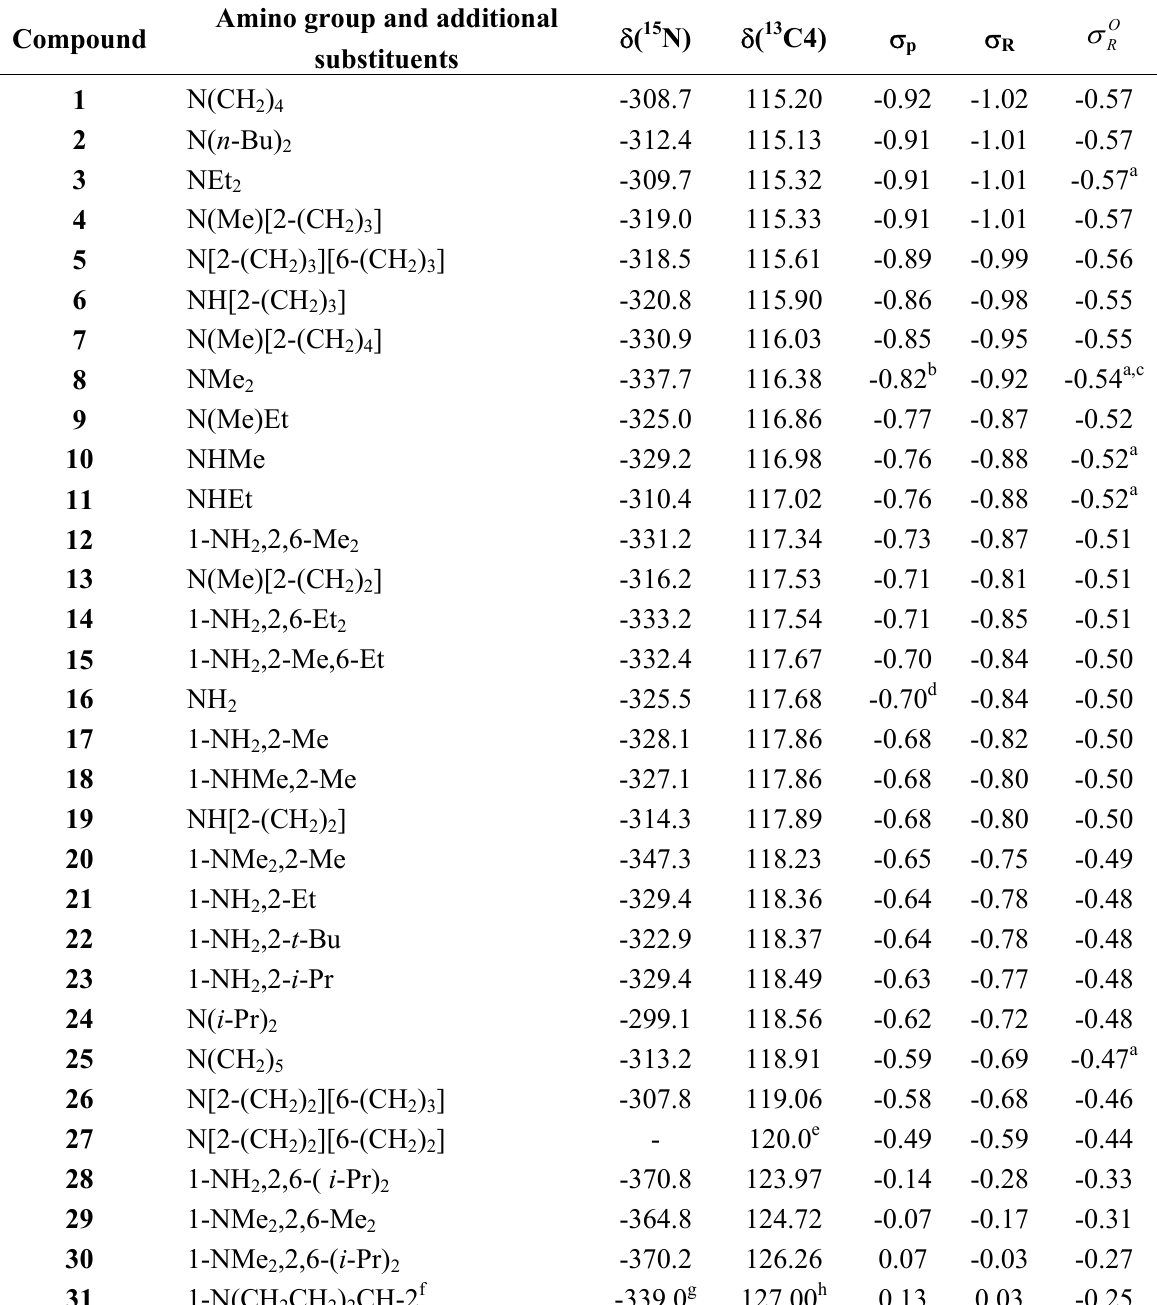
and substituent constants 1